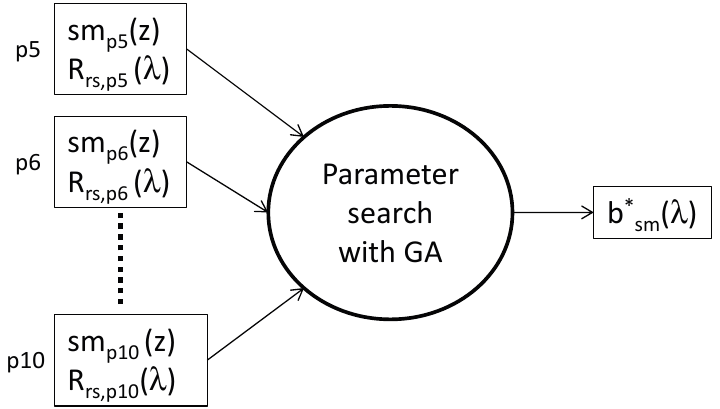
Figure 5. Scheme of the usage of the genetic algorithms (GA) for the retrieval of the mass-specific scattering coefficient, using as input data vertical profiles and reflectance at 16 wavelengths from six sampling